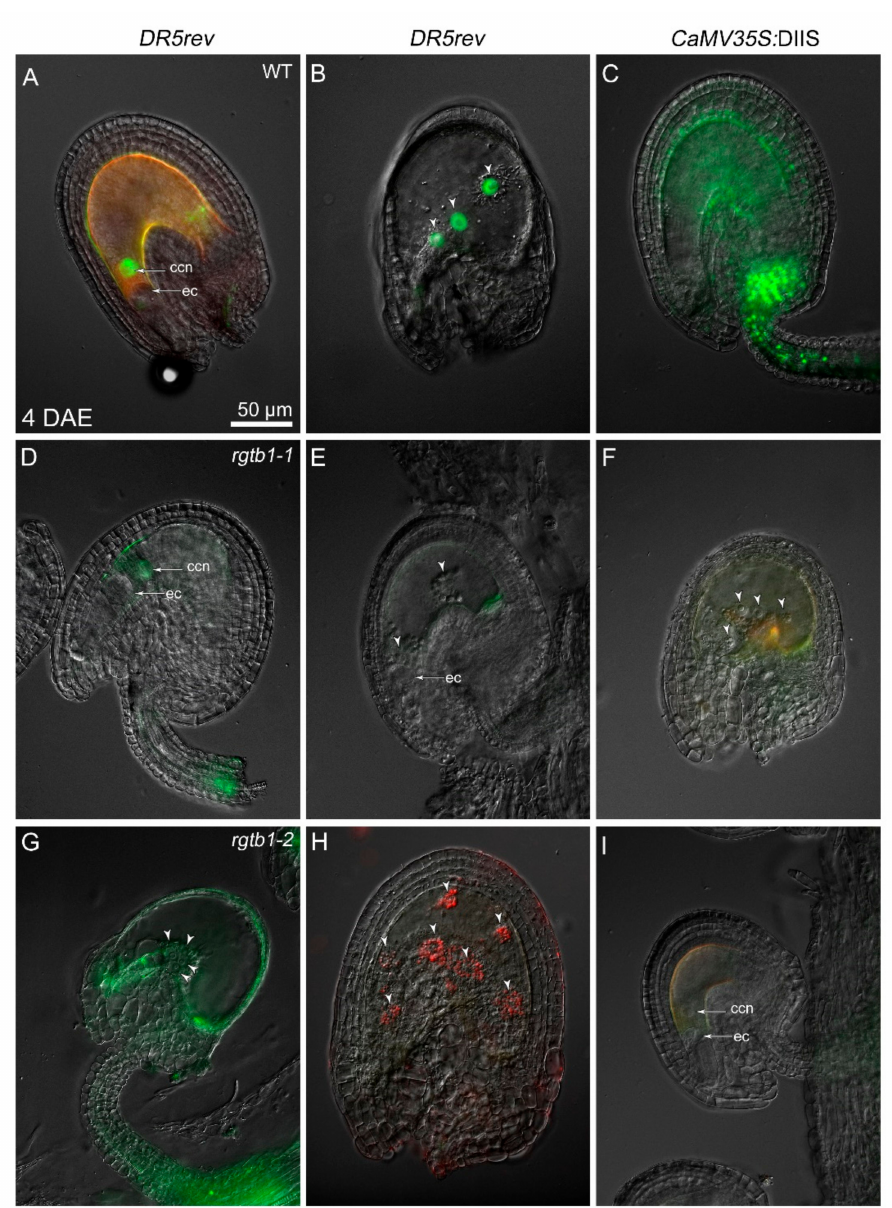
Figure 5. rgtb1 ovules resemble ovules in emasculated WT plants . Ovules 4 days after manual emasculation (4DAE) of flowers. ( A , B ) Auxin reporter pDR5rev :3xVenus-NLS signal, marking canonical auxin-dependent transcription response, is present in the central cell nucleus of unfertilized WT flowers ( A ) and autonomous endosperm nuclei formed in ovules of emasculated WT flowers ( B ). ( C ) DIIS-Venus auxin reporter (green) is present in the integuments of unfertilized ovules, marking an absence of auxin. ( D , E , G , H ) pDR5rev :3xVenus-NLS signal is absent or weak in the central cell nucleus ( D ) of the unfertilized rgtb1 ovules or AE nuclei ( E , G , H ), shown by the white arrowheads, marking an absence of auxin transcription response. ( F , I ) DIIS-Venus signal is absent from the sporophytic tissues of the unfertilized rgtb1 ovules, both forming AE nuclei ( F ), as shown by the white arrowheads), and non-forming AE ( I ), marking the presence of auxin in them. Fluorescence microscopy—all images; pDR5rev :3xVenus-NLS (green) or DIIS-Venus (green) as indicated, unspecific fluorescence (red). The scale bar of 50 µ m in ( A ) is the same for all images. Abbreviations: ccn—central cell nucleus, ec—egg cell, DAE—days after emasculation. Autonomous endosperm in rgtb1 / rgtb1 ovules from emasculated flowers initiated with a similar frequency compared to non-emasculated flowers, but was higher than